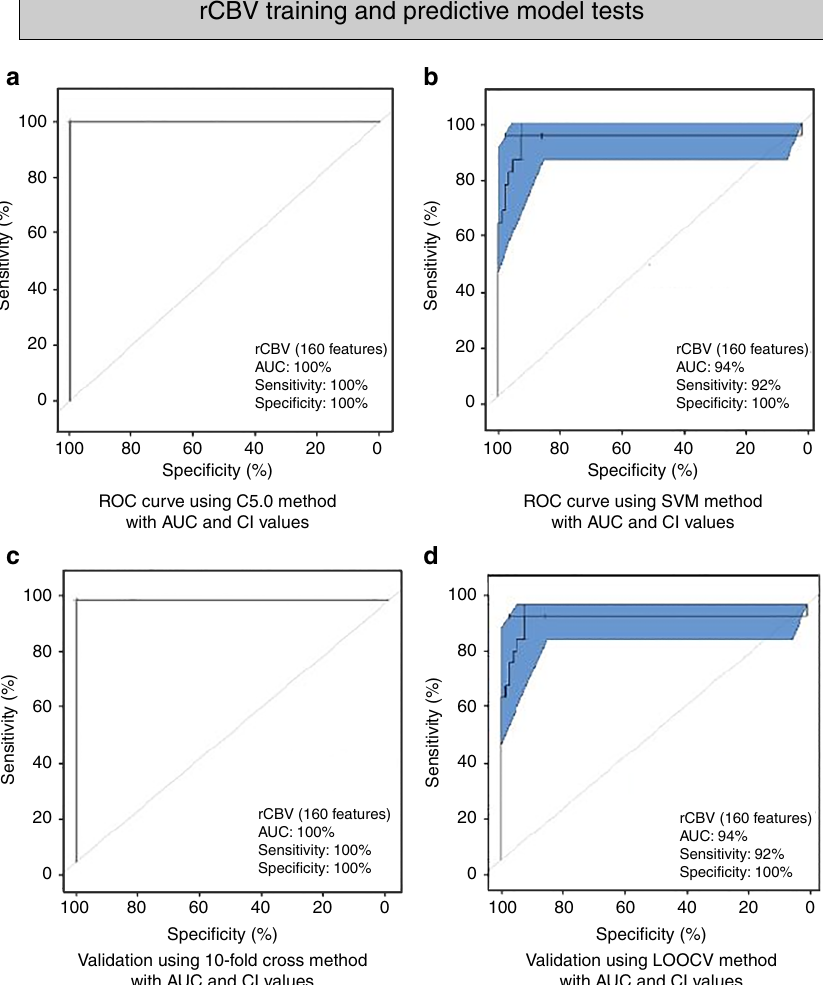
Fig. 3 Model building and evaluation using the selected rCBV features (160 features). a , b ROC curve depicts the predictive model building using C5.0 ( P -value 1.512e − 11) and SVM methods ( P -value 0.012) respectively. c , d 10-fold cross-validation ROC curve ( P -value 1.512e − 11) and Leave-One-Out Cross-Validation (LOOCV) ROC curve ( P -value 0.012) depicts the performance of the